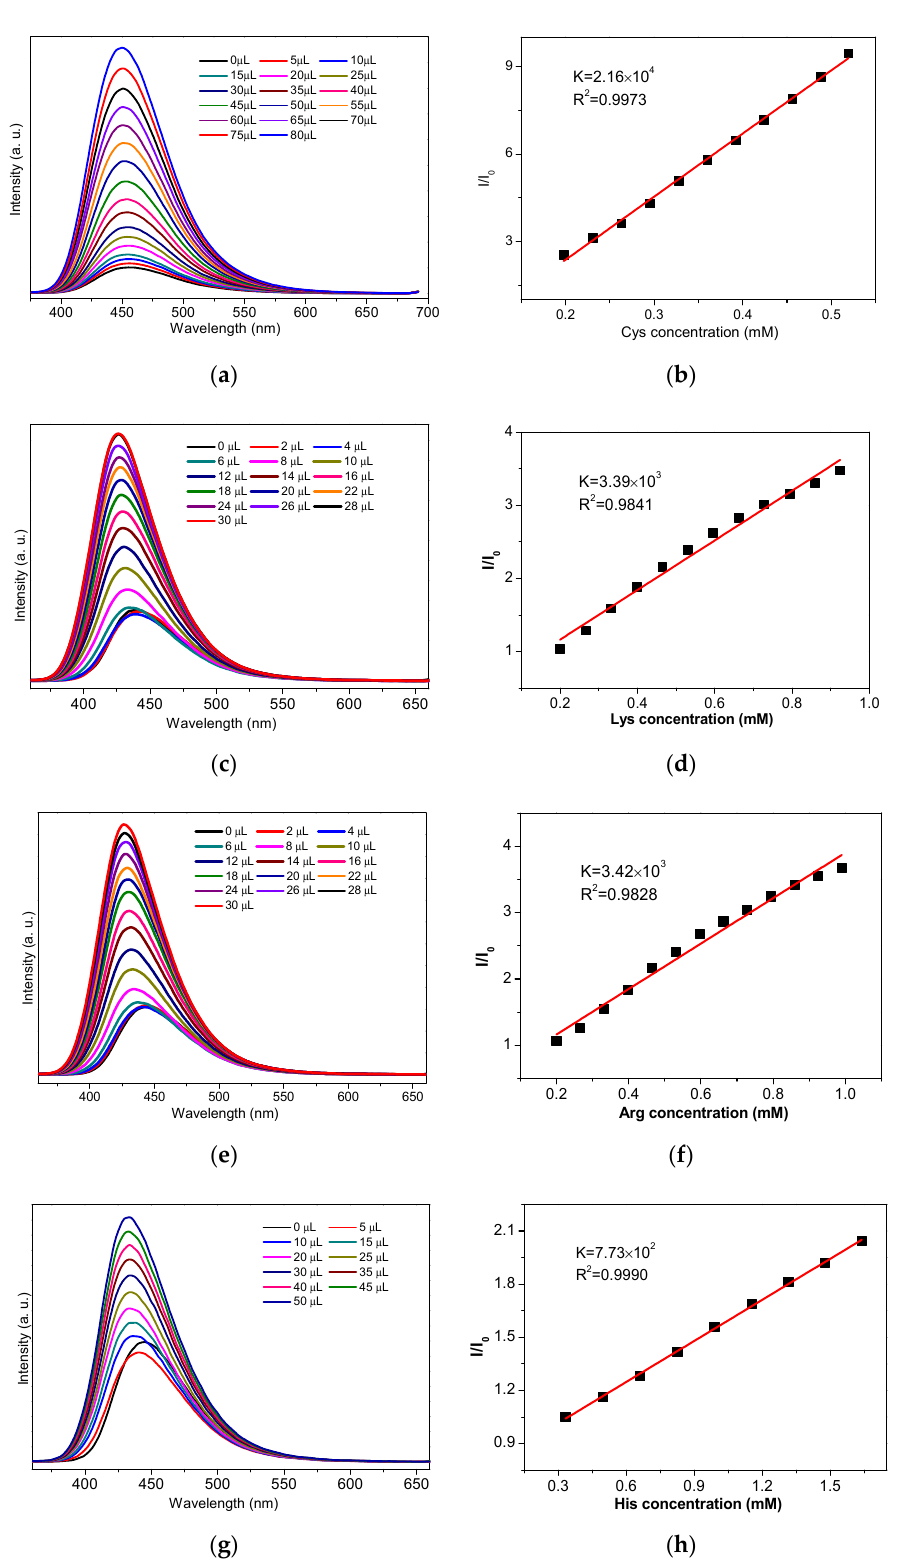
Figure 2. The changes in the emission intensity of the aqueous suspension of NH 2 -MIL-101-Fe upon the gradual addition of Cys ( a ) excited at 356 nm. The changes in the emission intensity of the aqueous ethanol suspension of NH 2 -MIL-101-Al upon the gradual addition of Lys ( c )/Arg ( e )/His ( g ) excited at 340 nm. The I / I 0 versus the concentration plots of Cys ( b )/Lys ( d )/Arg ( f )/His ( h ). (The emission spectra of NH 2 -MIL-101-Al were obtained by using an optical attenuator owing to the measuring range of fluorescence